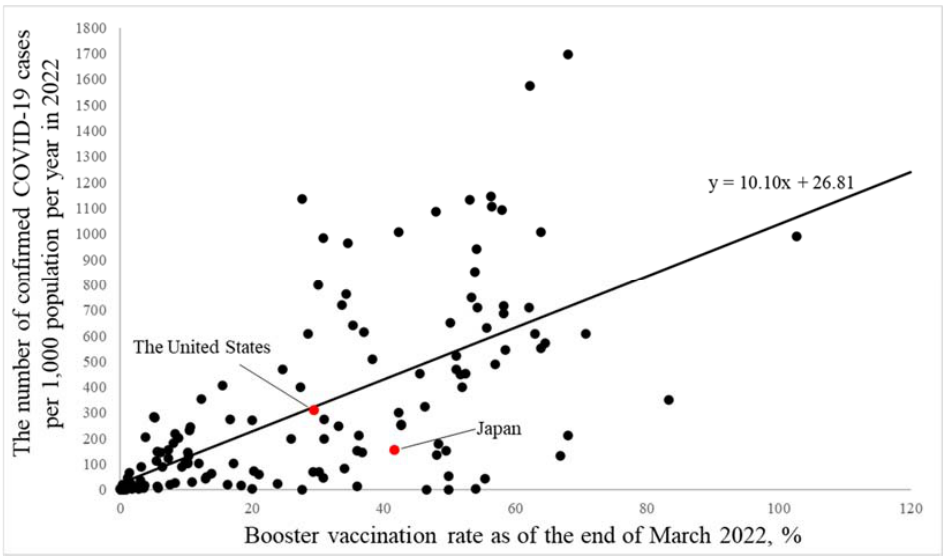
Figure 2. An international association of booster vaccination rate with the number of confirmed COVID-19 cases per year in 2022 in the world. The line shows the slope based on the generalized regression model as an approximated curve. The covariate was not included in this